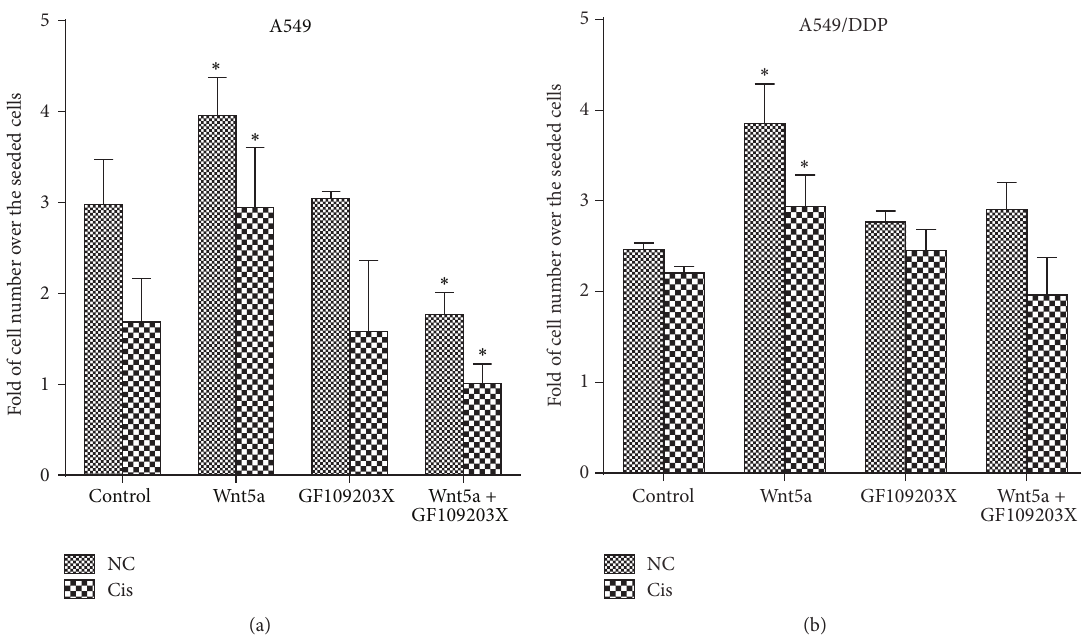
Figure 1: Wnt5a promotes lung cancer cell proliferation. Lung cancer cell line A549 and A549/DDP cells were cultured in 96-well plate at a density of 2×10 4 per well and cultured in Wnt5a-CM and/or medium containing GF109203X. The proliferation of cells was then determined in terms of CCK assay. (a) The cell proliferation in A549 cells in the absence or presence of cisplatin. (b) The cell proliferation in A549/DDP cells in the absence or presence of cisplatin. Wnt5a showed an ability to promote cell proliferation, and GF109203X inhibited the Wnt5a- induced proliferation. Wnt5a-CM could increase cell proliferation in A549 and A549/DDP cells. Compared to a Control-CM treated control cells, ∗ represents 𝑝 < 0.05 . Data represented the mean ± SD from three independent triplicated experiments ( 𝑁 = 9 ). GF: GF109203X.